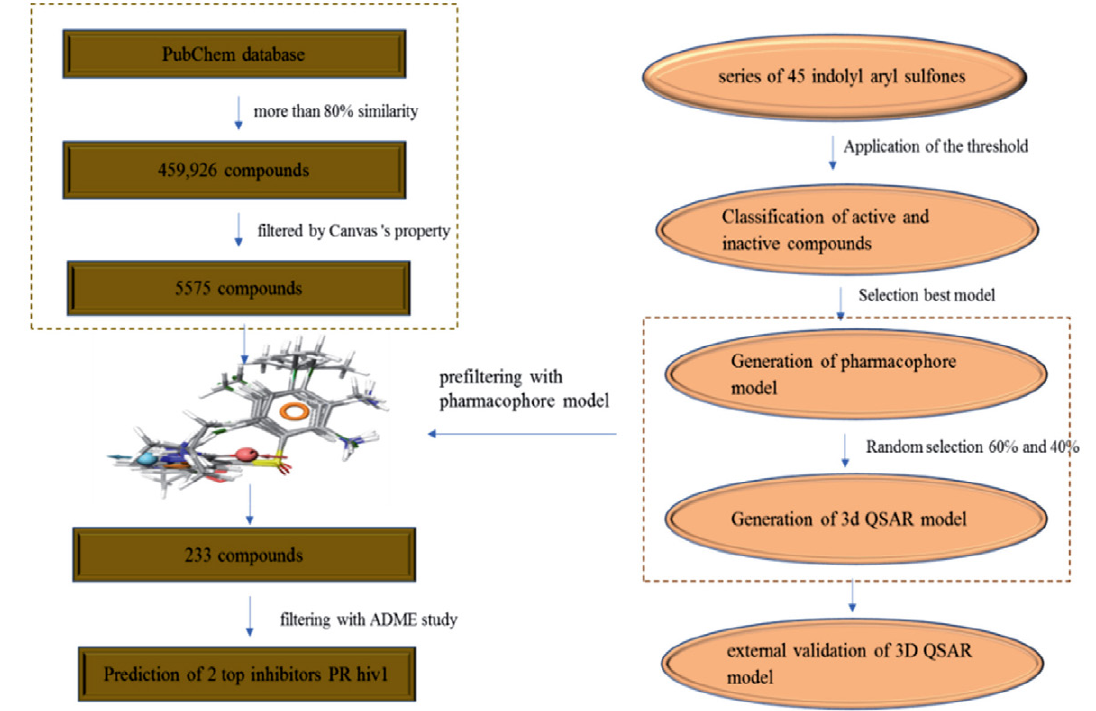
Fig. 1. Schematic representation of the methods followed in the current